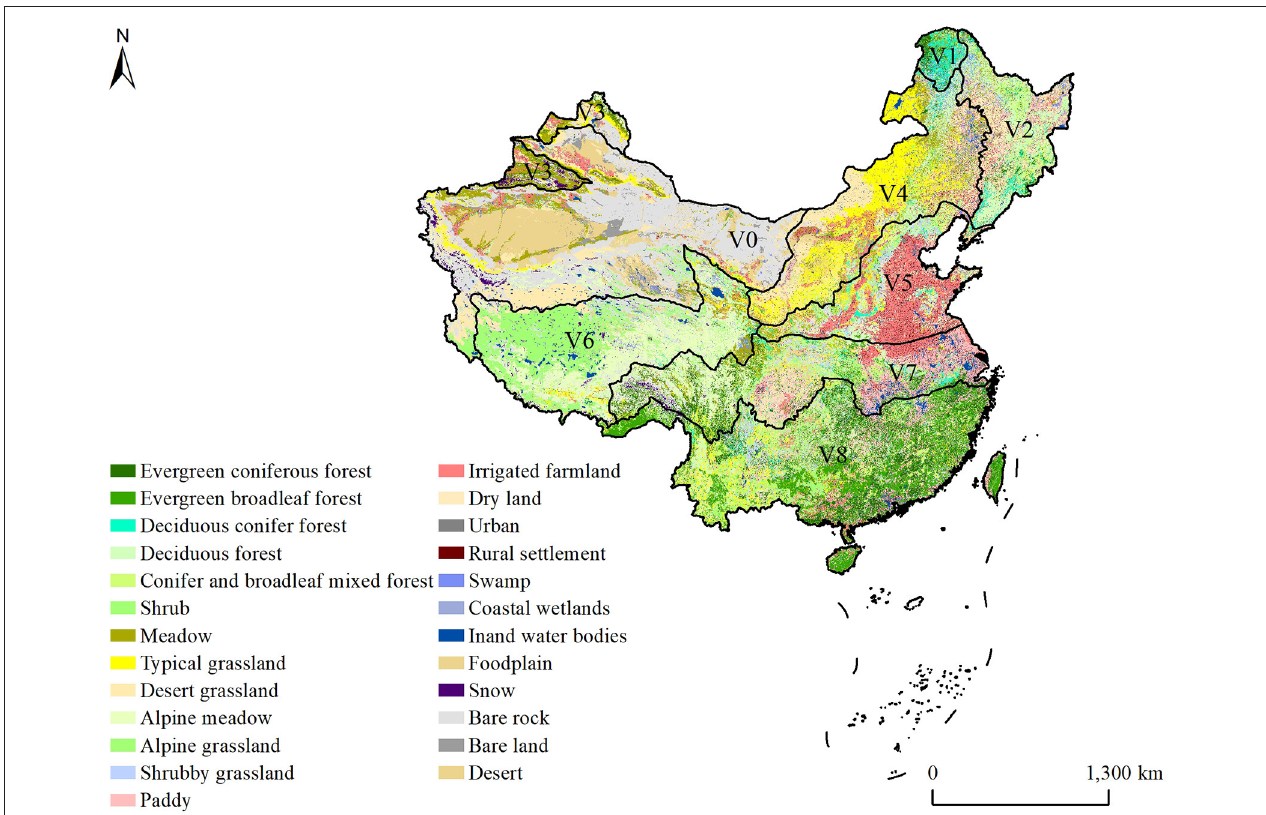
FIGURE 1 | Forest cover in